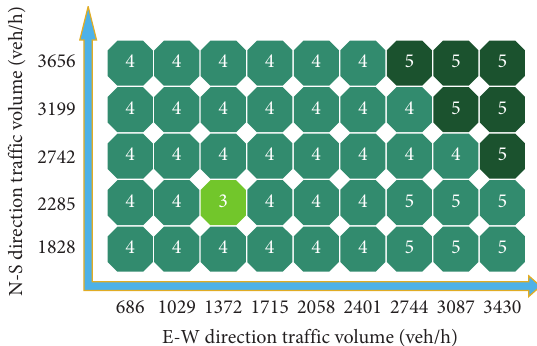
Figure 15: Recommended schemes’ matrix diagram. The figure shows the recommended schemes in the different traffic